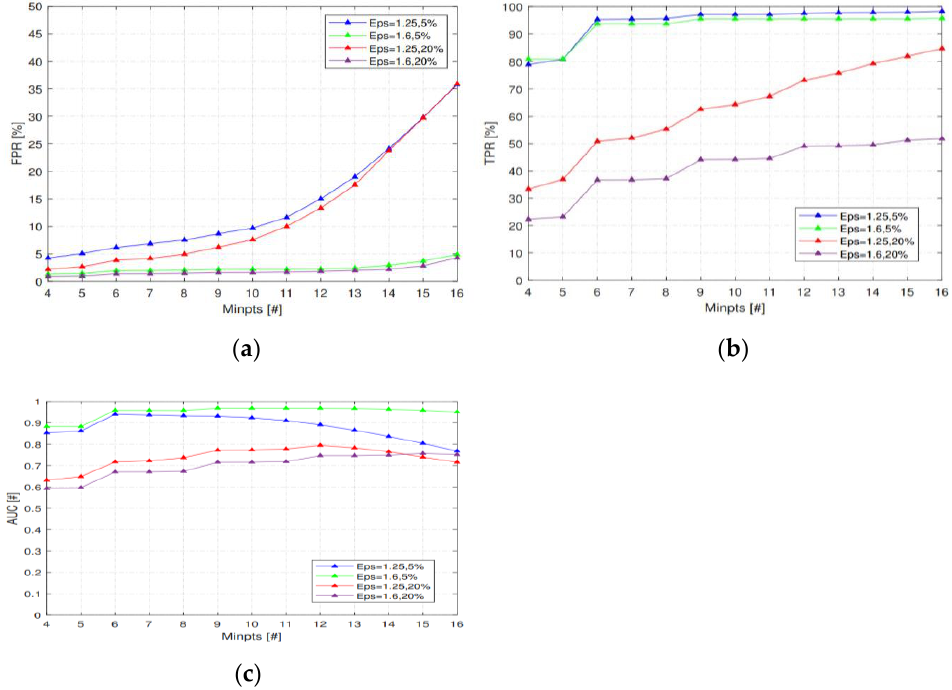
Figure 8. ( a ) The effects of MinPts on TPR; ( b ) The effects of MinPts on FPR; ( c ) The effects of MinPts on AUC.